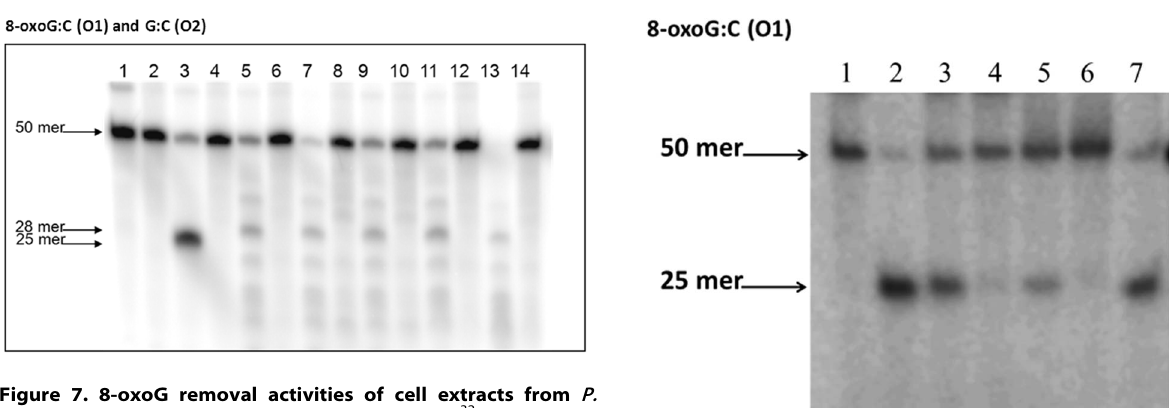
nucleotide 3 9 to the site of damage. Following the 3 9 incision,